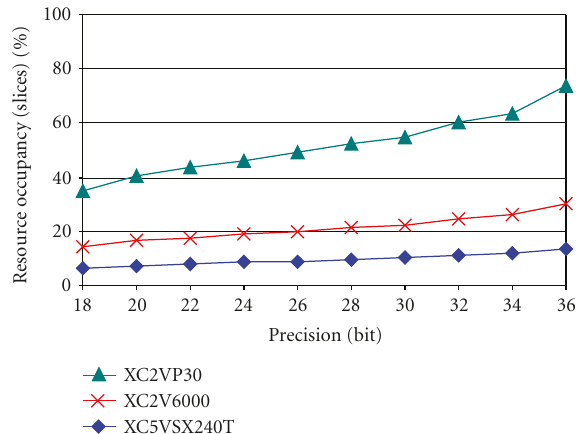
Figure 8: Logical resource (slice) requirements on di ff erent FPGAs.